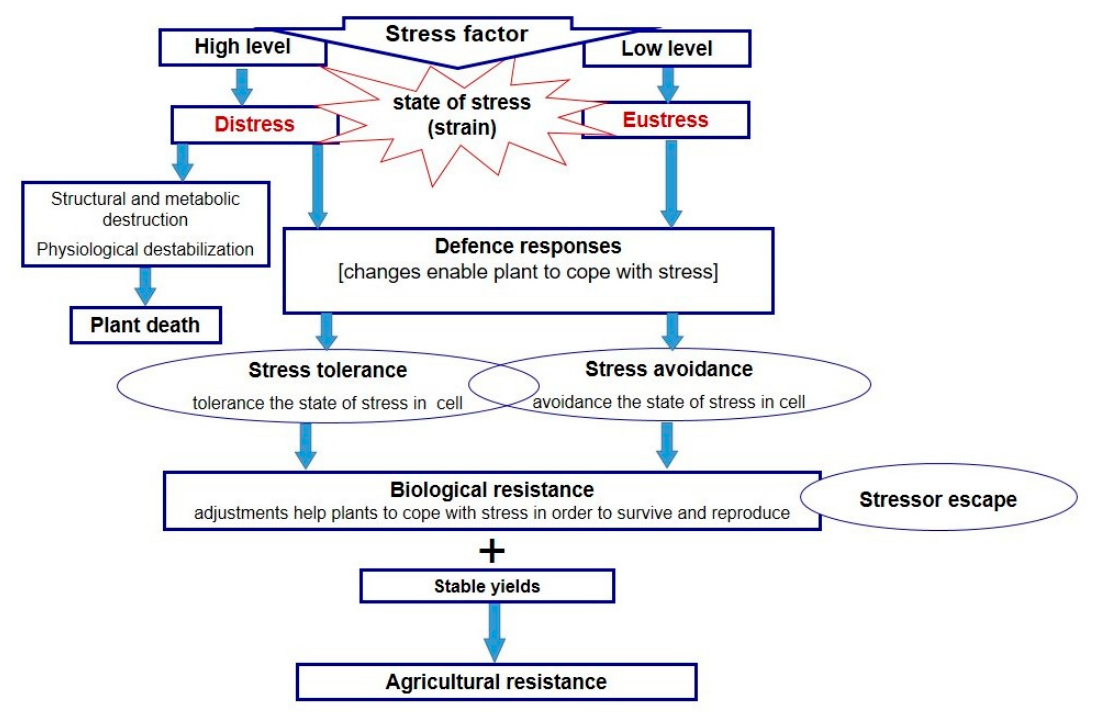
Figure 2. Plant responses to abiotic stress factors, coping strategy, and resistance.